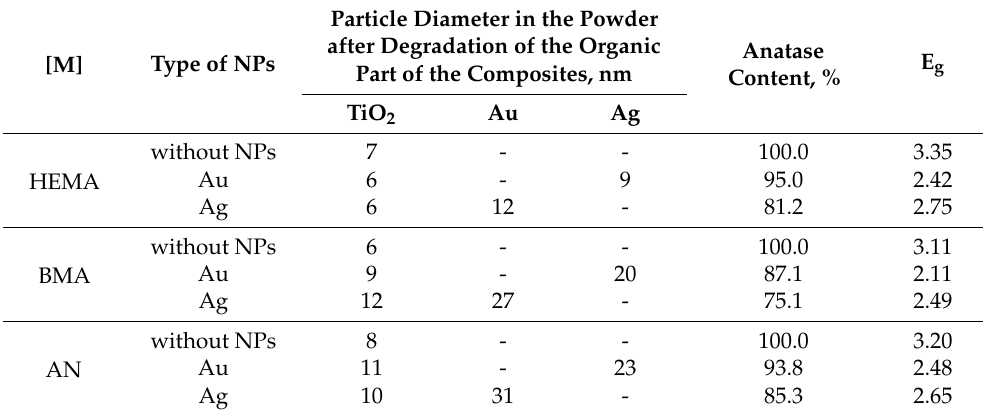
Table 1. Particle sizes in powders after degradation of the organic part of nanocomposites of composition [( ≡ TiO) n ]:[HEMA]:[M], containing Au or Ag